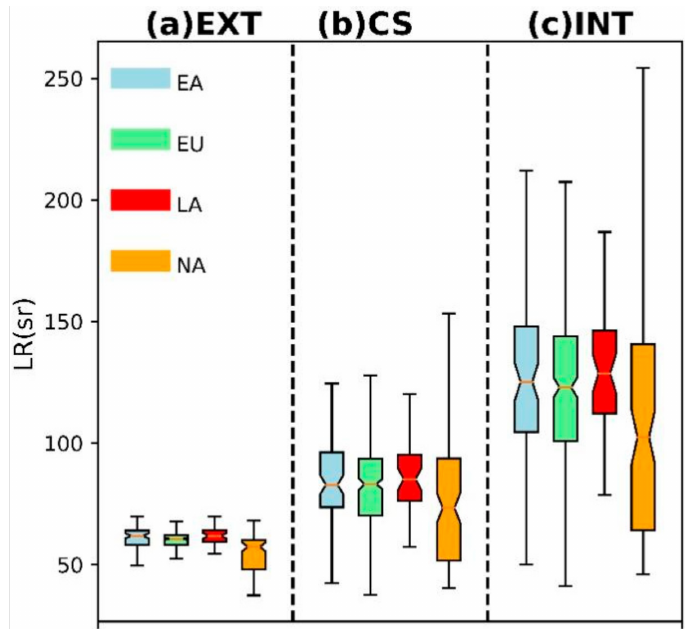
Figure 1. Representative PNSDs in different regions. The representative samples of the four regions Figure 2. Values of the LR of all samples in different regions under the condition of f EC = 0.1. EXT, in the figure are the median value of the PNSD. CS, and INT represent the external, core-shell, and internal mixing states,